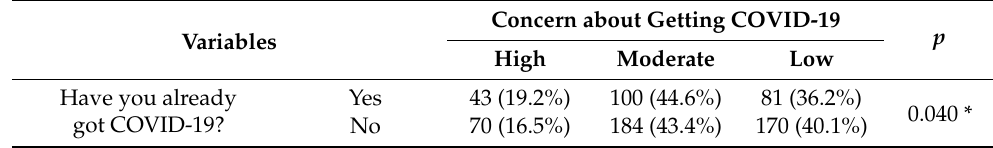
Table 9. Association between concern about the spread of COVID-19 and previous contagion of